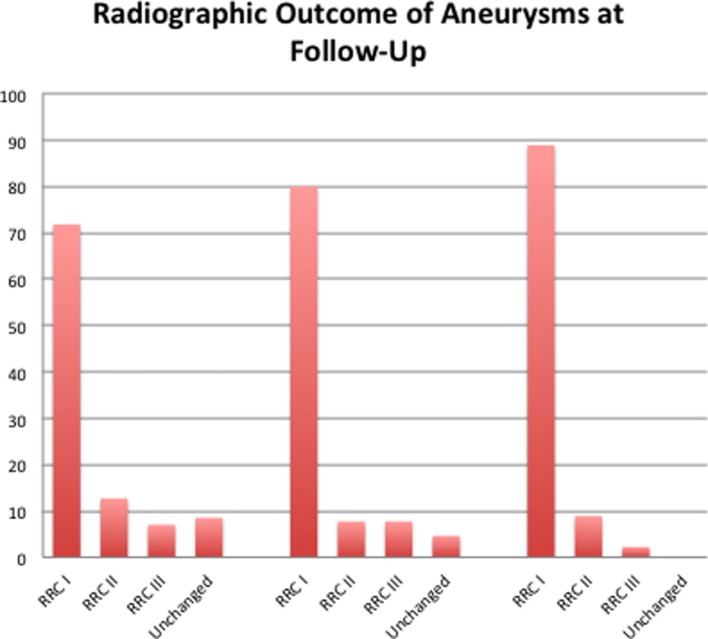
The percentage of aneurysms with Raymond-Roy occlusion grade I, II, or III at initial follow-up (mean 96 days postop, n = 71), mid-term follow-up (mean 280 days postop, n = 65), and final follow-up (mean 953 days postop, n = 45). Increasing occlusion of the aneurysms can be seen over time.